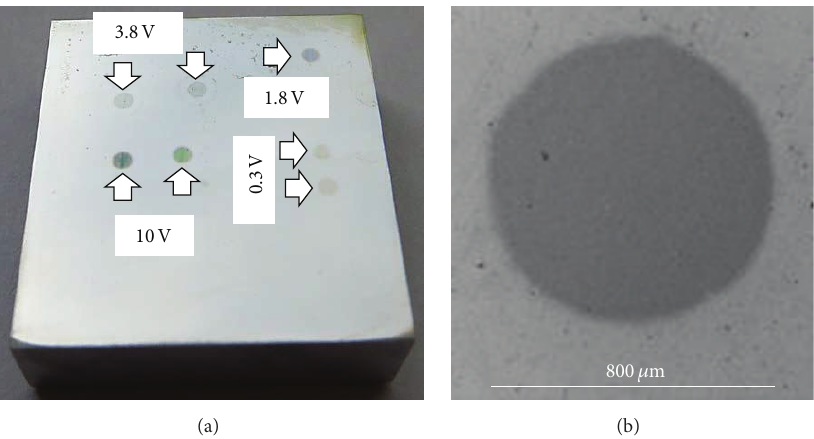
Figure 6: Photograph of the circular areas formed by micro-capillary anodising of EN AW-7075 T73 in the potentiostatic regime in 0.4M sulphuric acid at 0.3V, 1.8V, 3.8 V, and 10 V for 600 s showing interference colours from tan to blue and green under broadband incident light due to their film thickness (a) and an example in SEM imaging (b).